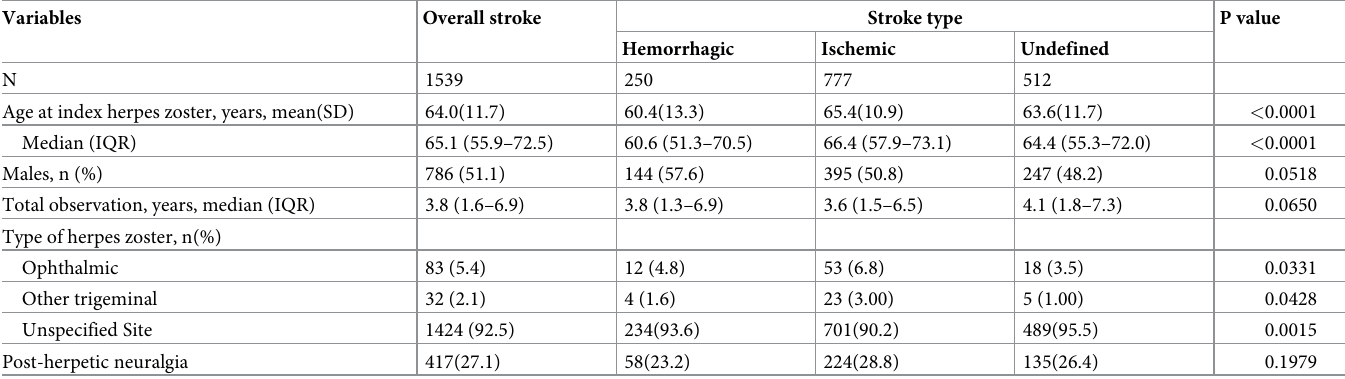
Table 3. Characteristics of stroke patients with herpes zoster.